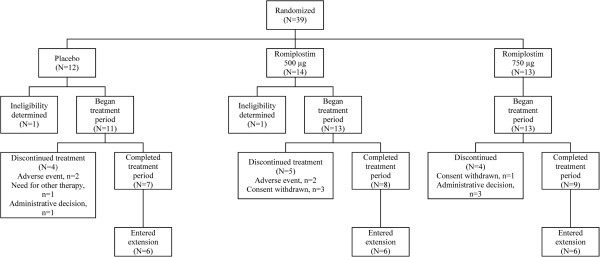
Patient disposition.